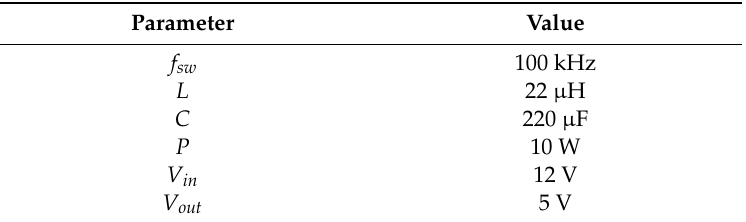
Table 1. Buck Converter Parameters.